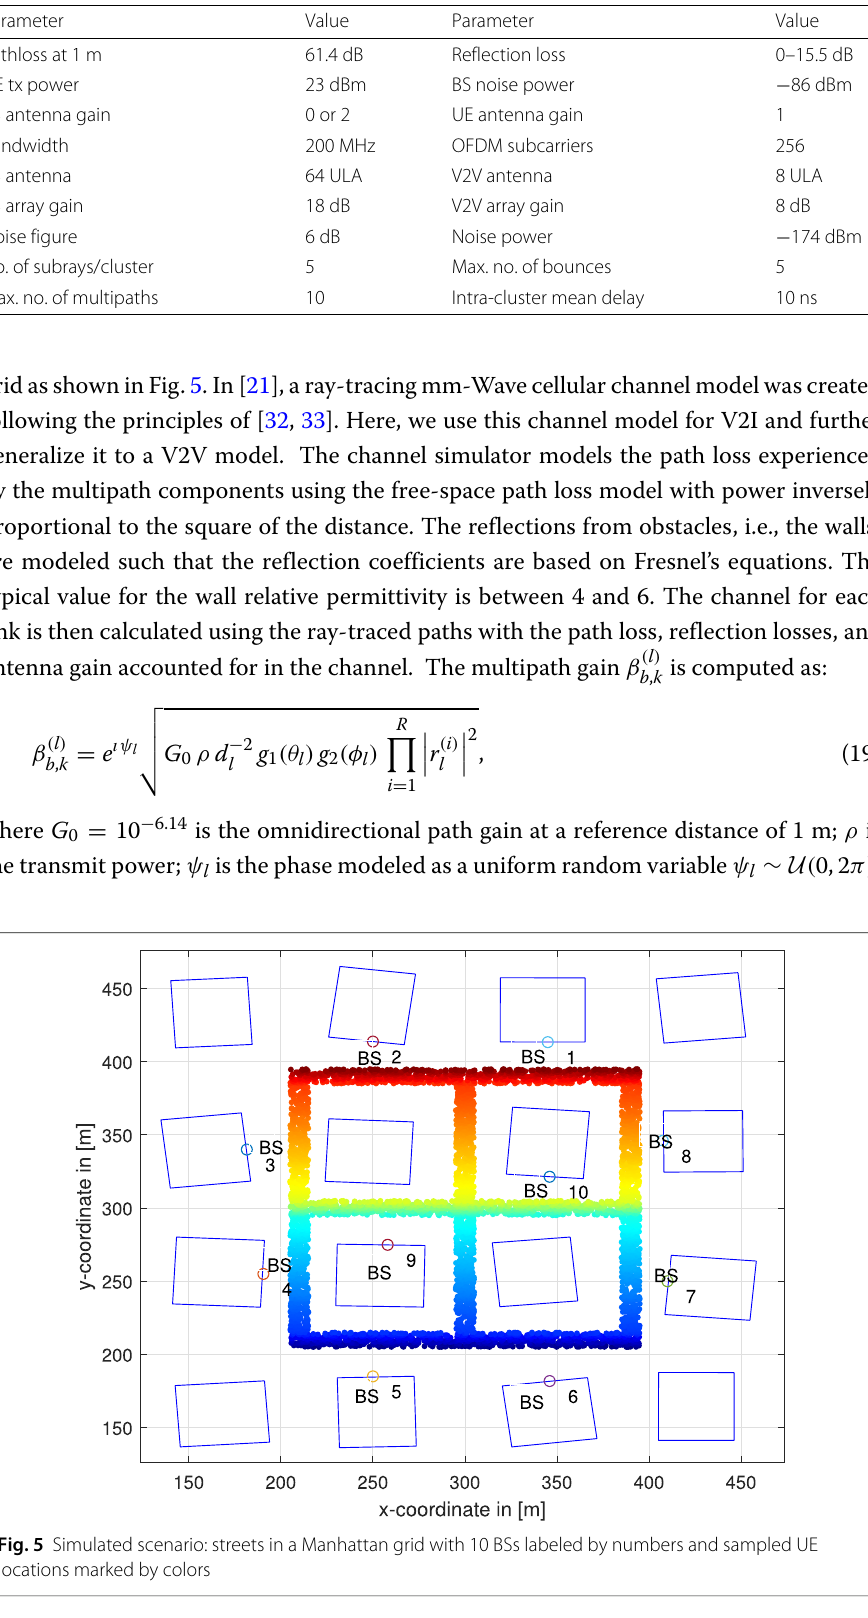
Table 2 Simulation parameters [21]